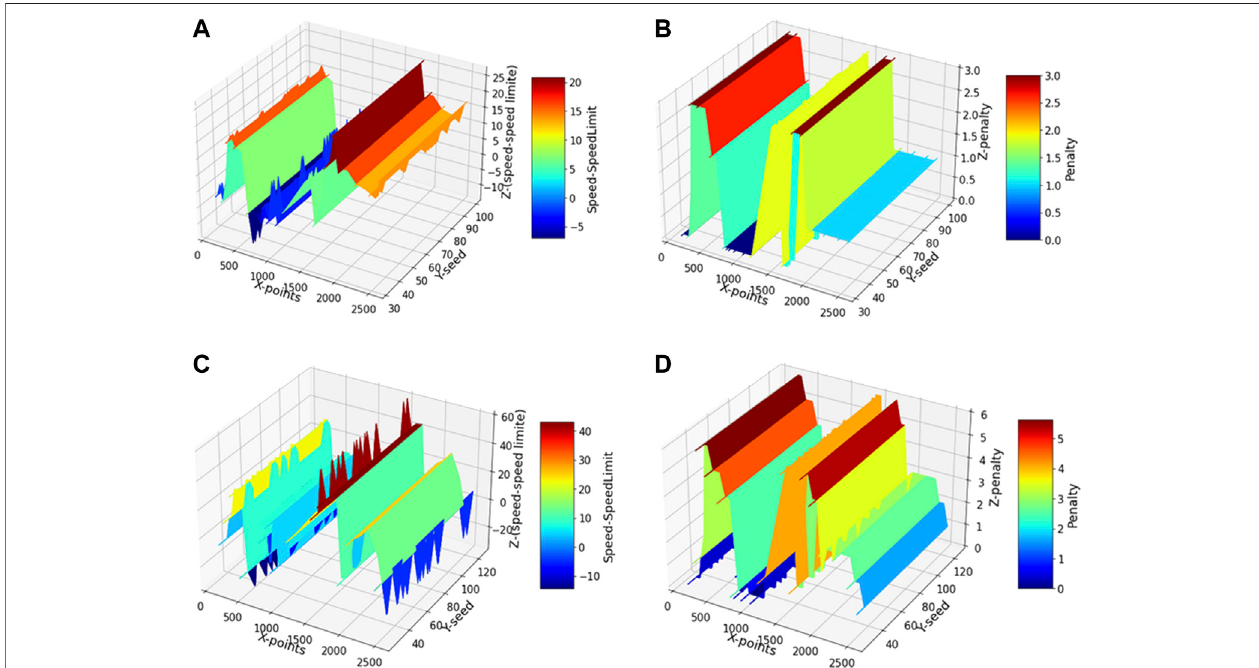
FIGURE 8 | Visualization of driving performance with respect to speed limits and